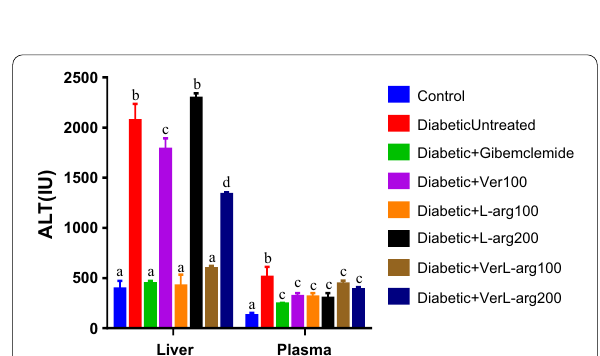
Fig. 14 Alanine-amino transferase activity in diabetic mice treated with verbenone, L-arginine and ratios of verbenone L-arginine (1:1 + v/m) after 14 days treatment. Values are expressed as mean SEM, ± n 5. Values with different superscripts are significantly different at = p < 0.05. VerL-arg verbenone L-arginine (1:1 v/m) = +